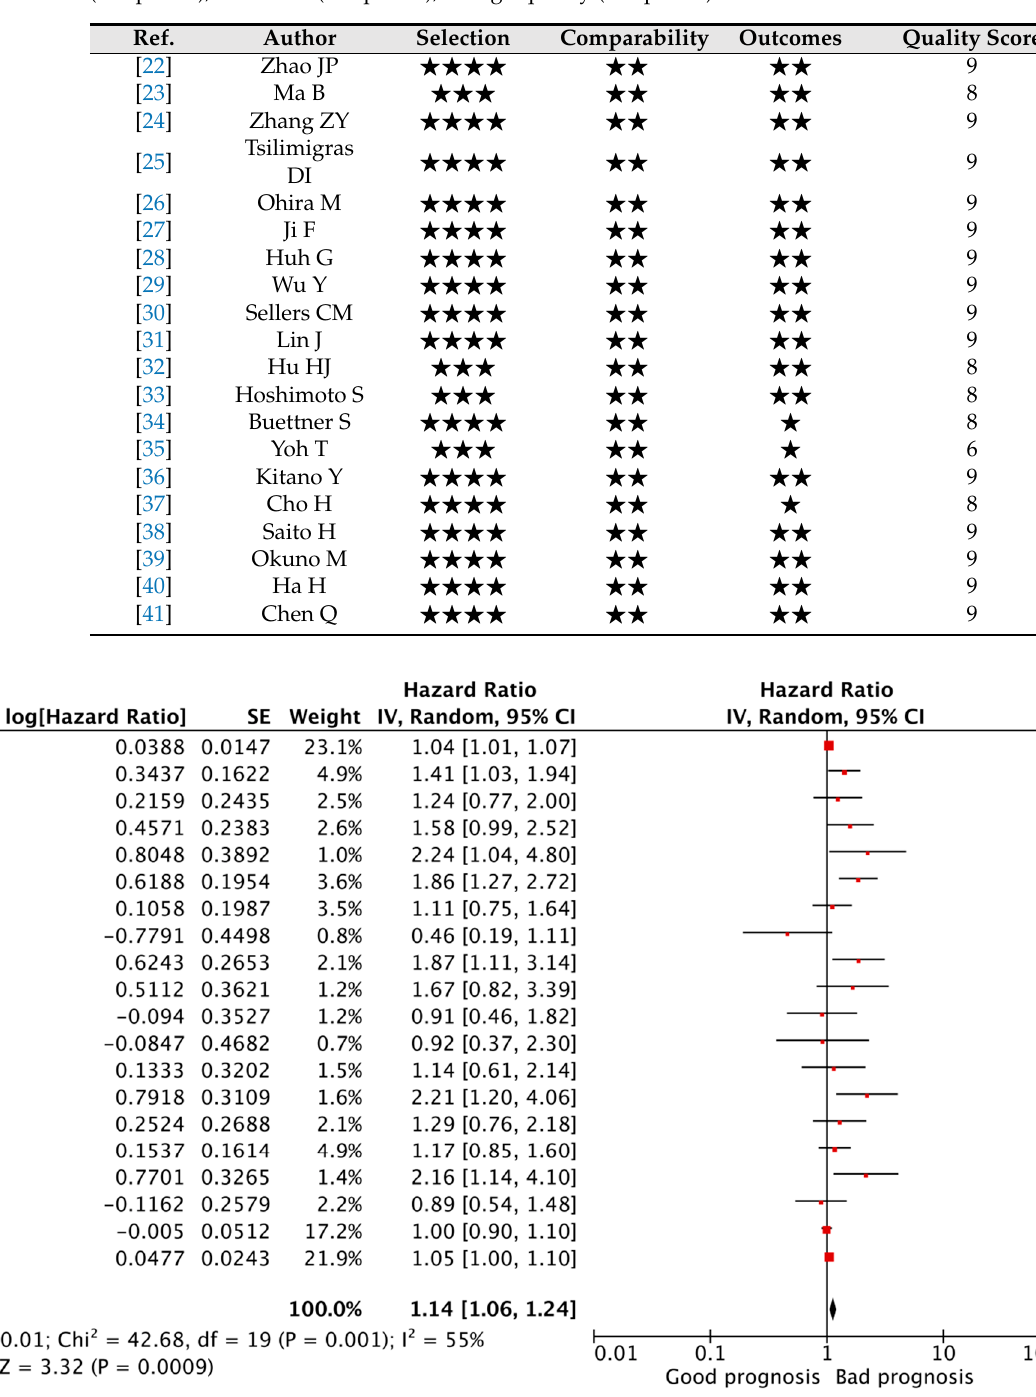
Figure 3. Forest plot of the correlation between PLR and DFS in CCA patients. A random-effects model was used to estimate the relationship between PLR and DFS. DFS, disease-free survival; PLR, platelet-to-lymphocyte ratio. 3.5. Subgroup Analyses of Correlation between the PLR and OS of CCA Patients As stated above, significant heterogeneity was observed in the HR of the OS for the PLR (I2 = 55%, p < 0.01, Figure 2) and the DFS for the PLR (I2 = 76%, p < 0.01, Figure 3). Considering the limited number of studies of DFS, we exclusively explored potential causes of the heterogeneity of the OS by subgroup analyses, focusing on cancer type, spe- cific treatment, PLR cut-off values, sample size, and age. First, we analyzed the significance of a high PLR with respect to OS for patients ac- cording to different cancer types, including CCA (combined analysis of iCCA and eCCA), iCCA, and eCCA. While statistical heterogeneity was observed in the eCCA subgroup (I2 = 60%, p = 0.03), with no significant correlation to OS, heterogeneity was not found in the